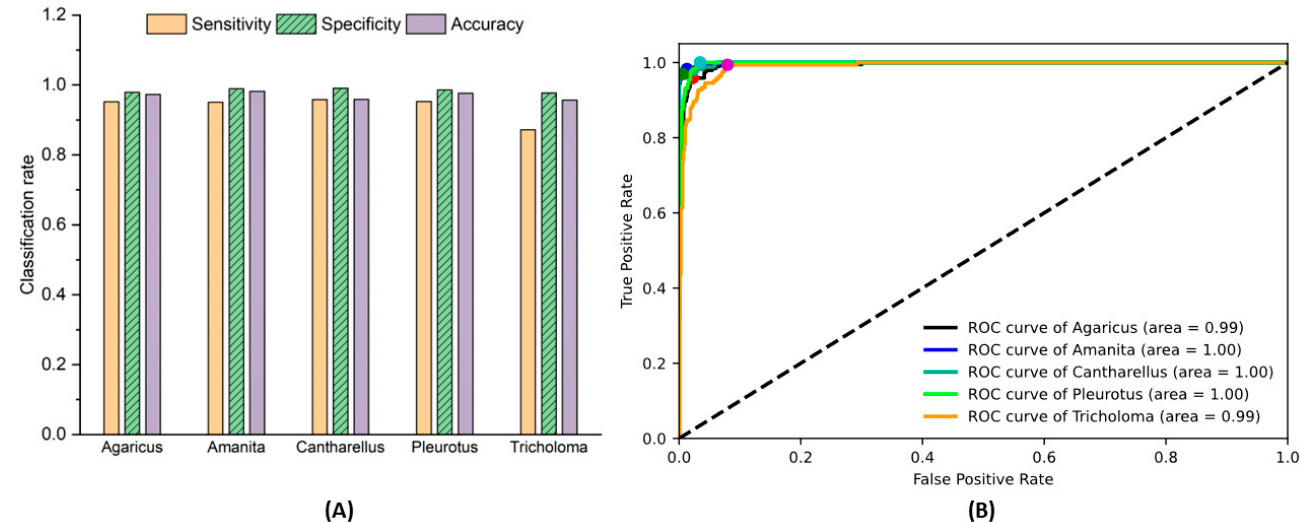
Figure 3. Comparison of sensitivity and specificity for the five classes of Agaricus , Amanita , Can- tharellus , Pleutrotus , and Tricholoma . ( A ) classification rate from server-based training and ( B ) receiver operating curve.